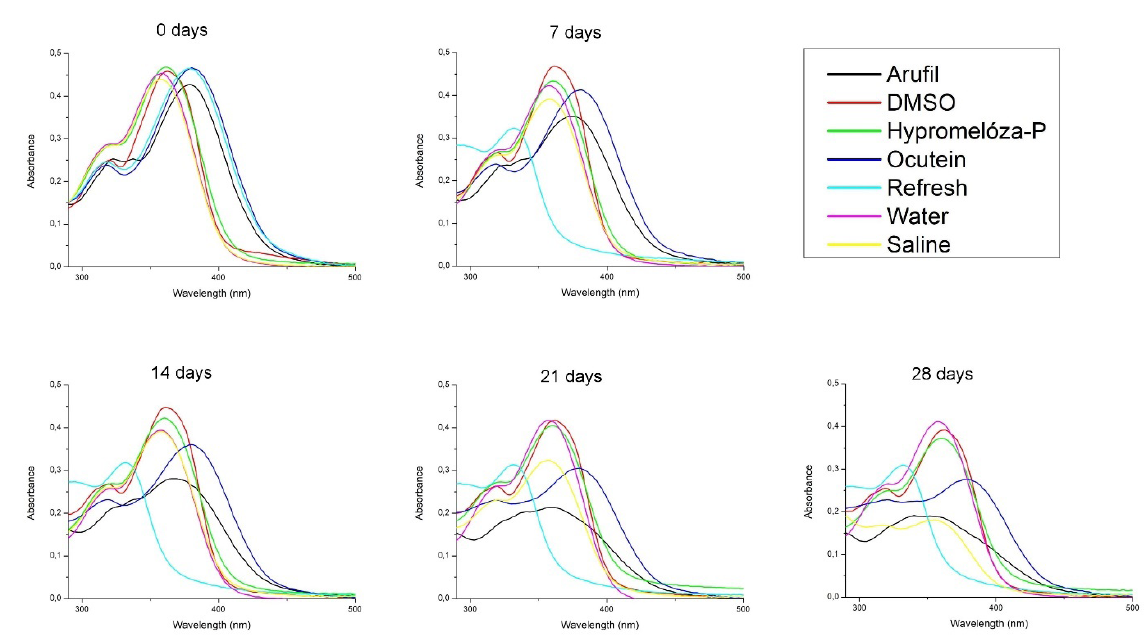
Figure 3: Absorption spectra of 25 M fisetin in eye drops (Arufil, Hypromelóza-P, Ocutein, Refresh), dimethylsulphoxide (DMSO), deionized water and normal saline solution (NSS) during four weeks. Fisetin was dissolved in DMSO (stock solution) and the solution was mixed with the respective volume of eye drops, DMSO, deionized water or NSS to obtain final 25 M fisetin concetration. Absorption spectra of fisetin in eye drops, DMSO, deionized water and NSS have been measured on the day of solutions preparation (0 days), after 7, 14, 21 and 28